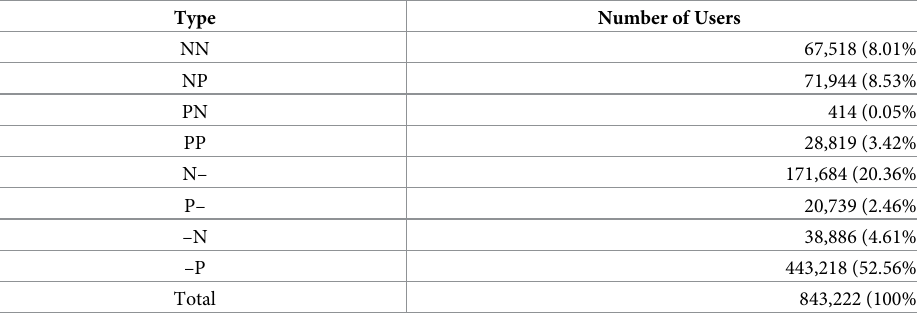
Table 3. Changes in attitudes toward the Olympic Games at the individual